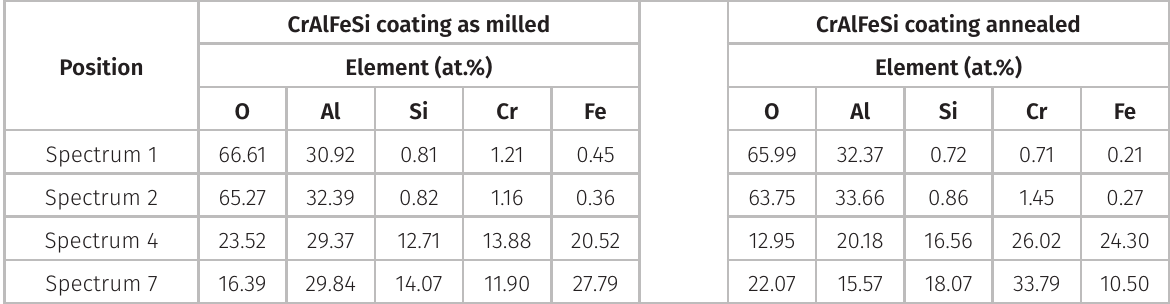
Figure 16. EDX point analysis of the coated substrate after oxidation for the coated substrate (a) before and (b) after annealing. Table V. EDX point analysis of Figure 11.